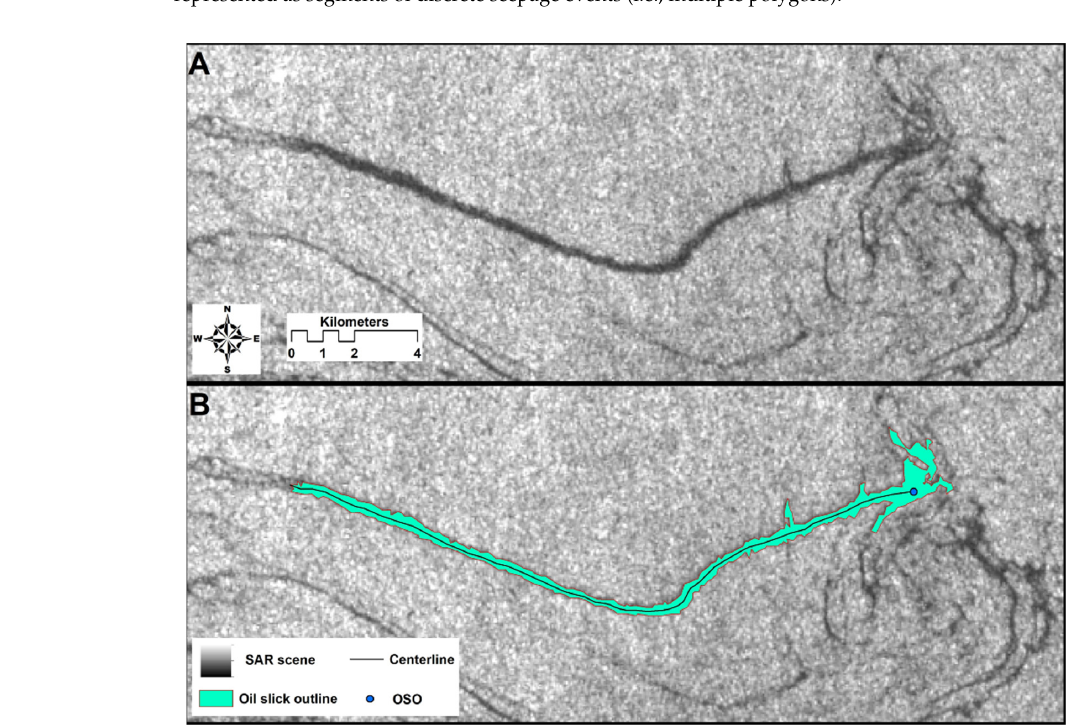
Figure 2. ( A ) Example SAR image with oil slick and ( B ) SAR image with natural oil slick polygon, centerline, and OSO.